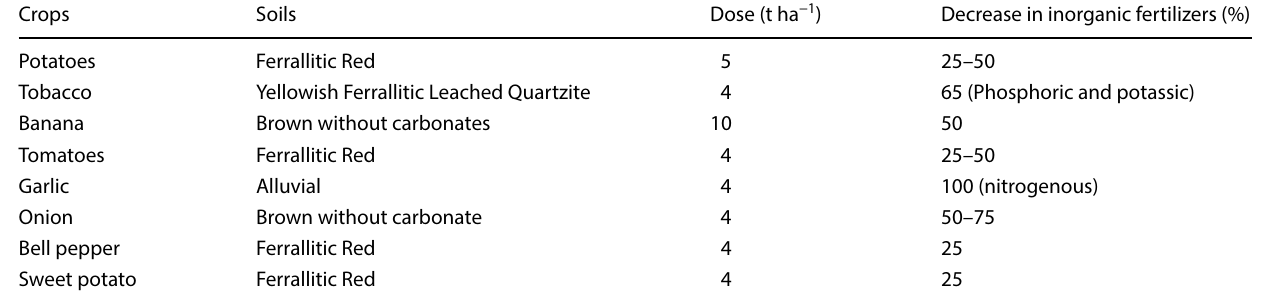
Fig. 1 Inorganic N fertilizer inputs to Cuba from 1961 to 1999 (data from the Interna- tional Industrial Fertilizer Asso- ciation, taken from Baisre,